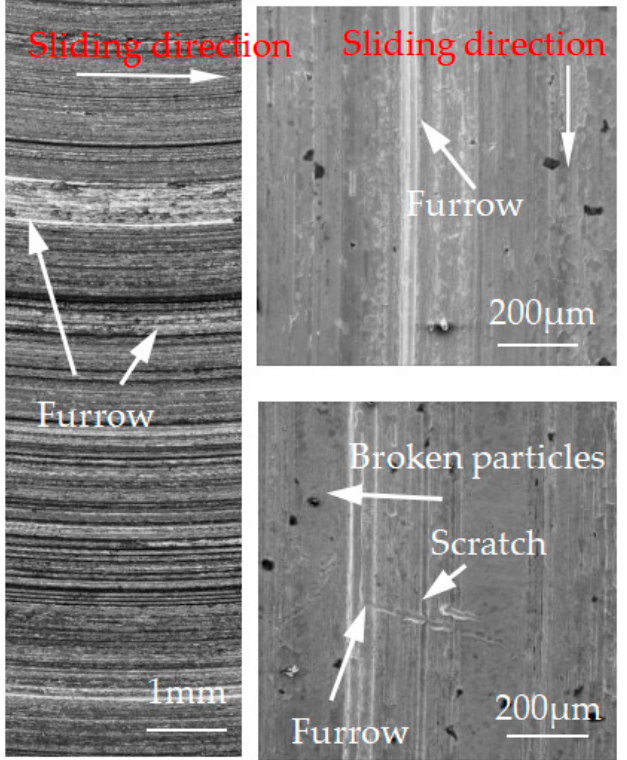
Figure 12. Surface morphology of the disc material after intermittent braking at an ambient temper- ature of 20 °C.